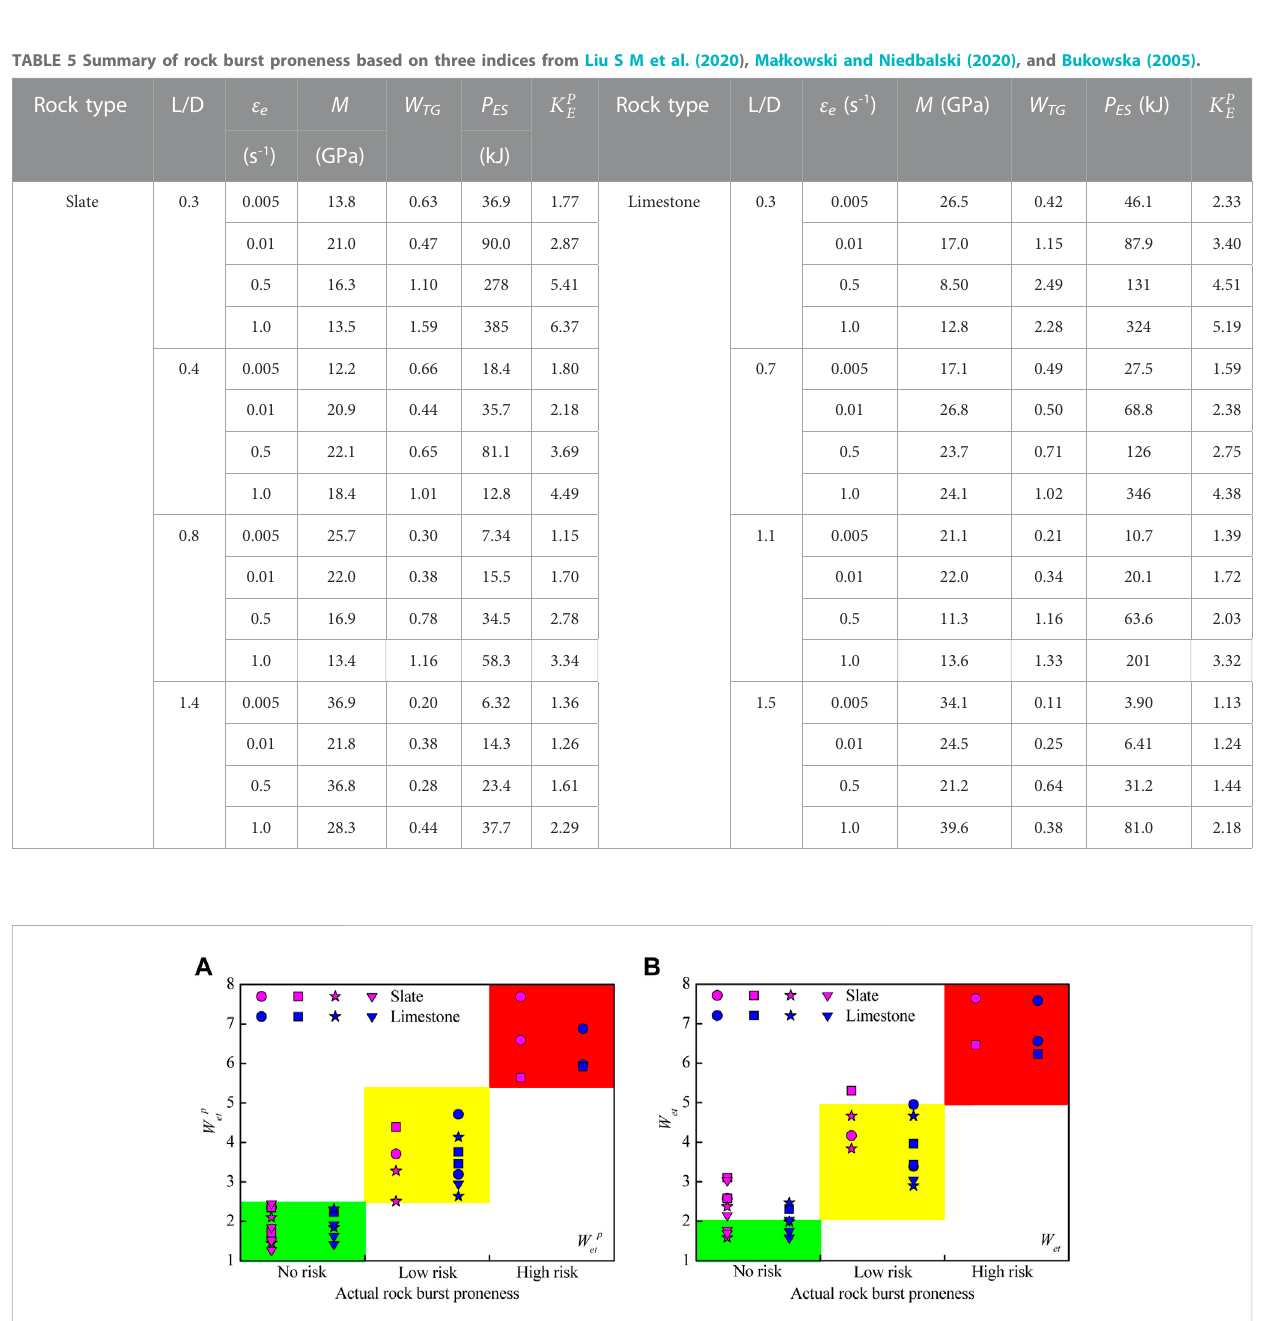
Frontiers in Earth